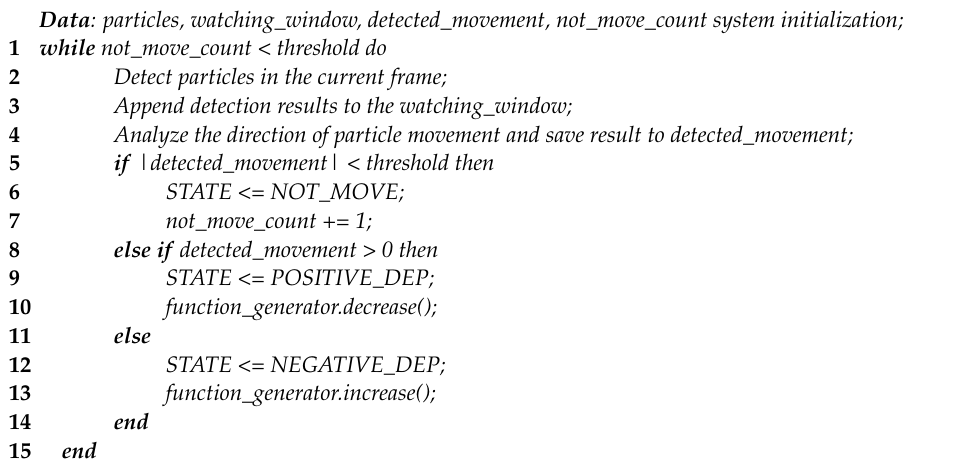
Algorithm 1 Pseudo code governing the control loop.